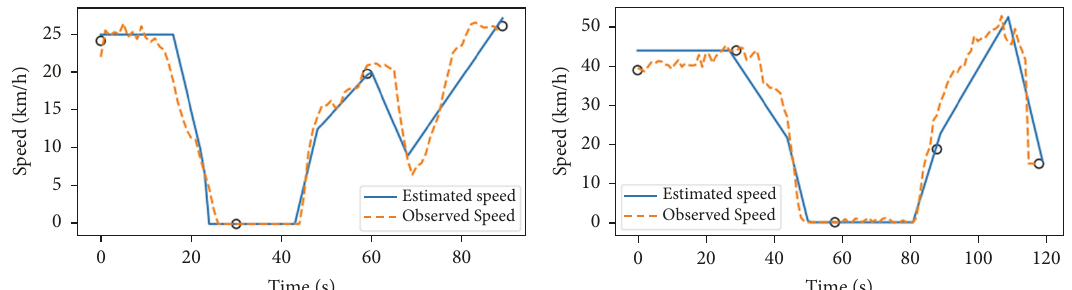
(b) Estimated and observed speed for trajectory with 5 sample points